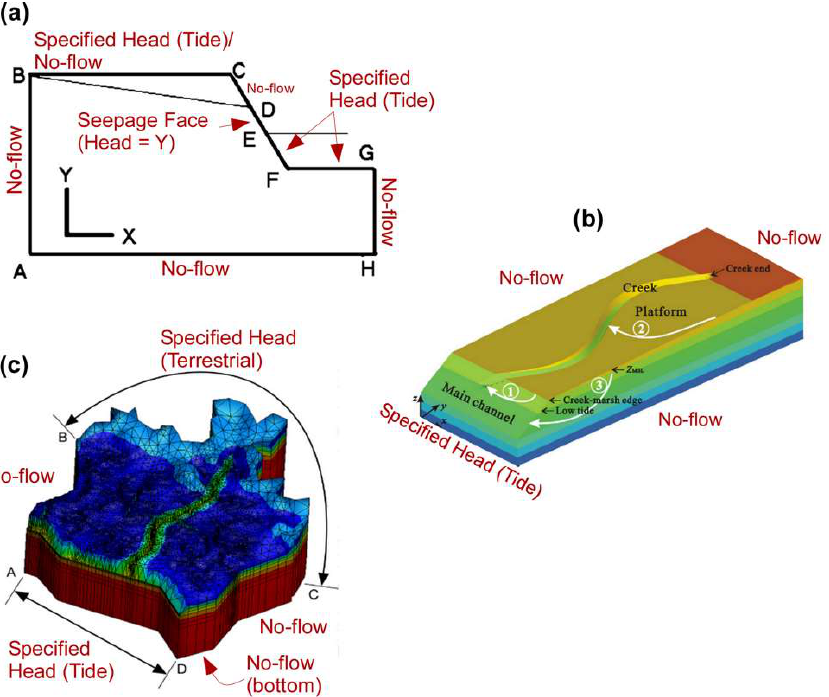
Figure 4. Examples of two- and three-dimensional model domains. Figures were modified from Gardner [72,86], Xin et al. [17], and Guimond et al. [62] for ( a – c ),